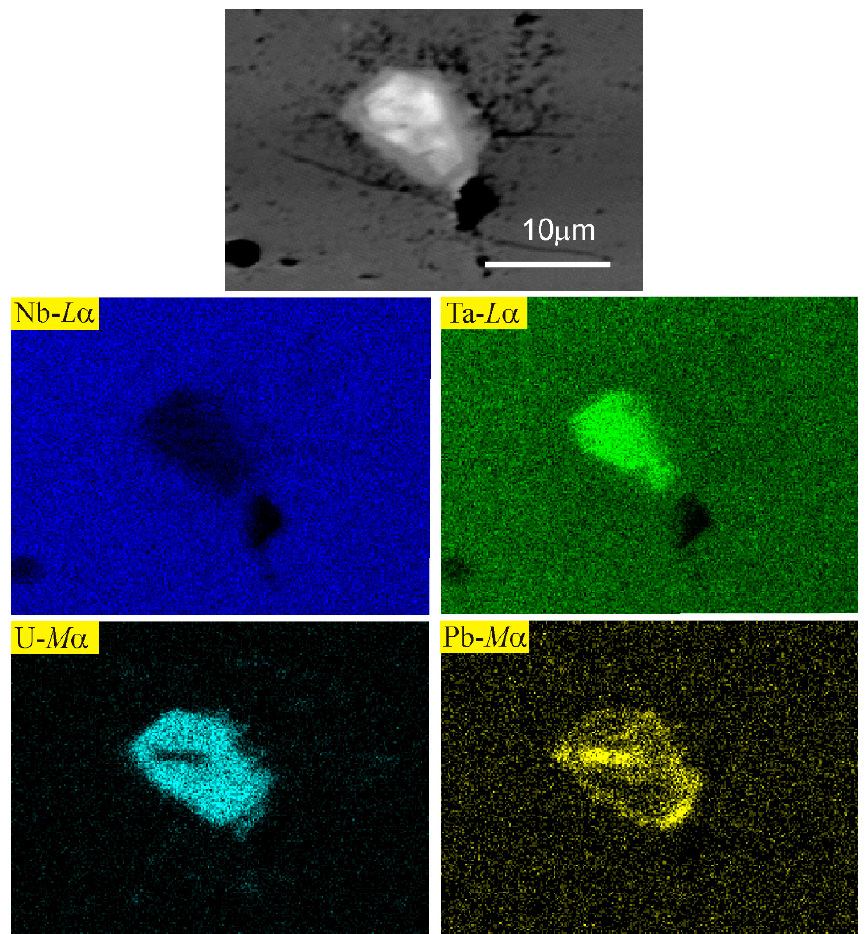
Figure 21. BSE images and elemental maps for a zoned grain of microlite replacing columbite. U-rich microlite is replaced by Pb-rich microlite.